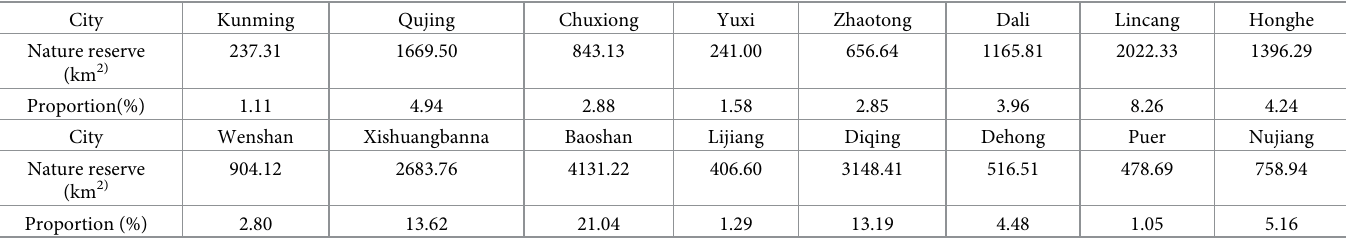
Table 4. Proportion of nature reserves in Yunnan